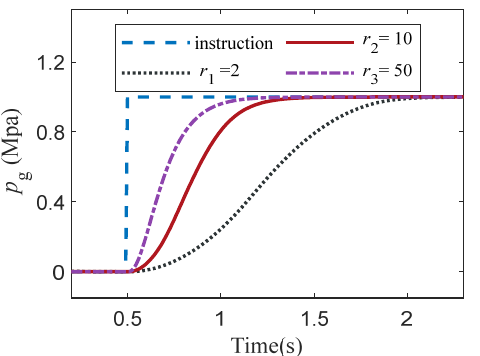
Figure 9. Comparison of signals before and after the arrangement transition process.